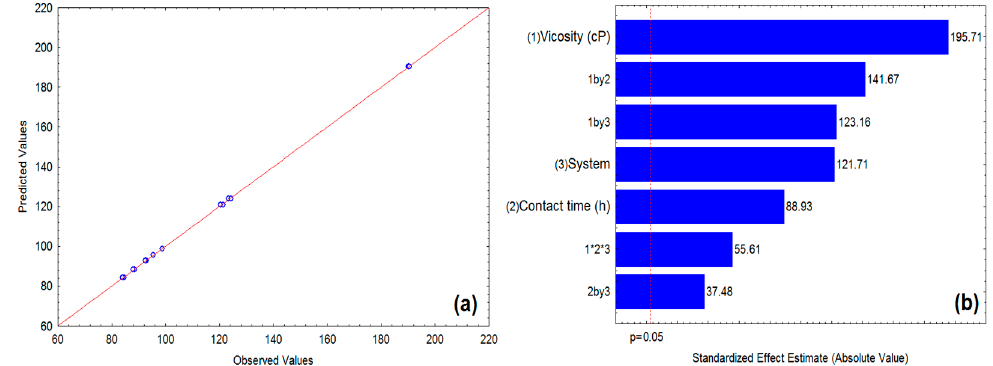
Figure 3. Relationship between experimental and predicted values for oil sorption ( a ) and Pareto diagram ( b ).